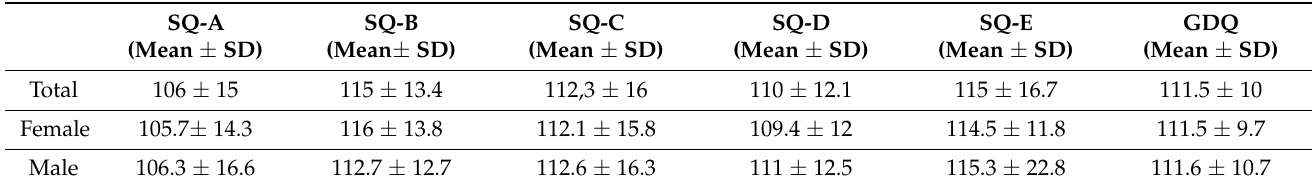
Table 1. Griffiths scales scores at 12 months.